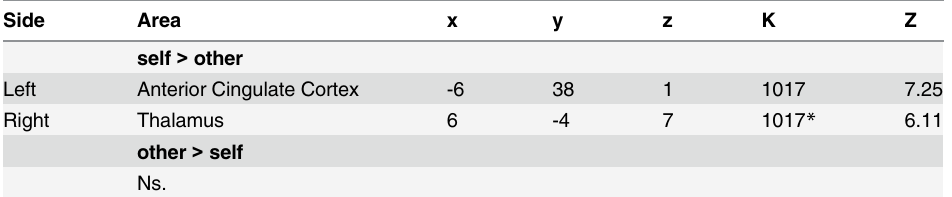
Table 4. Within-subjects group differences in activation: self-related vs. other-related activation (namely contrast: self > other ) and other-related vs. self-related activation (namely contrast: other > self